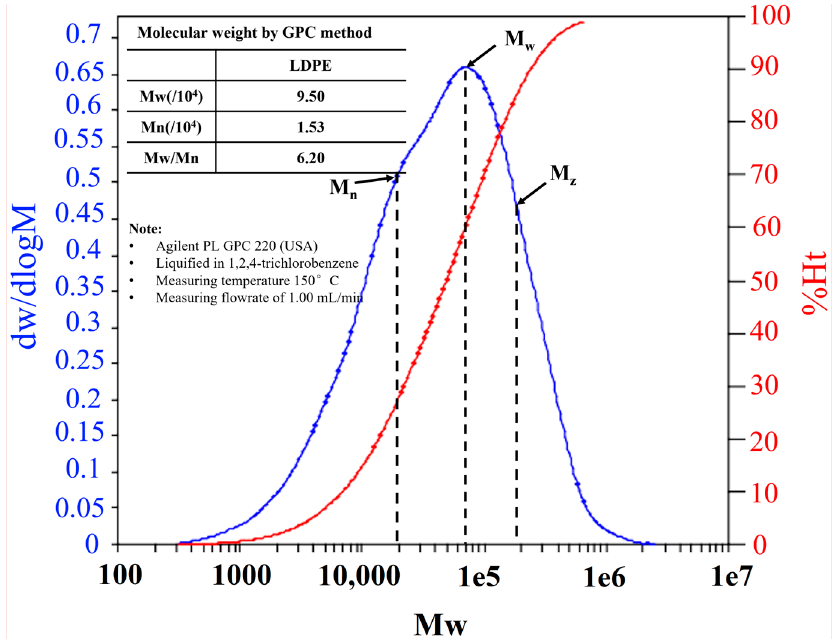
Figure 3. Molecular weight distribution of LDPE for the identification of molecular network density of XLPE by GPC technique.